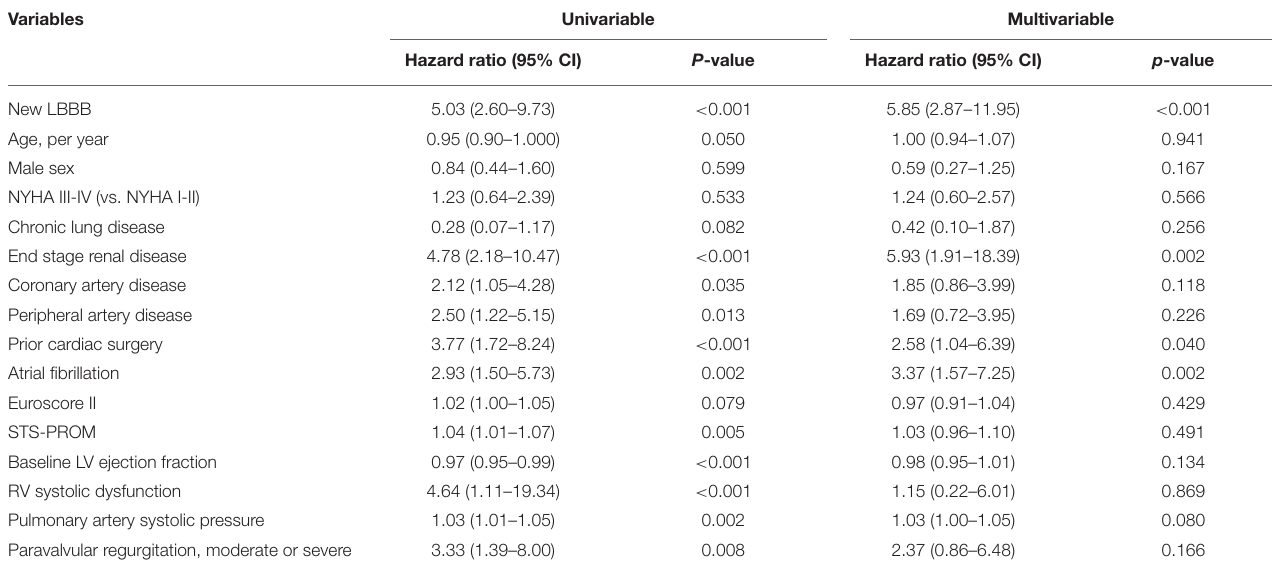
TABLE 4 | Univariate and multivariable predictors of clinical outcomes after